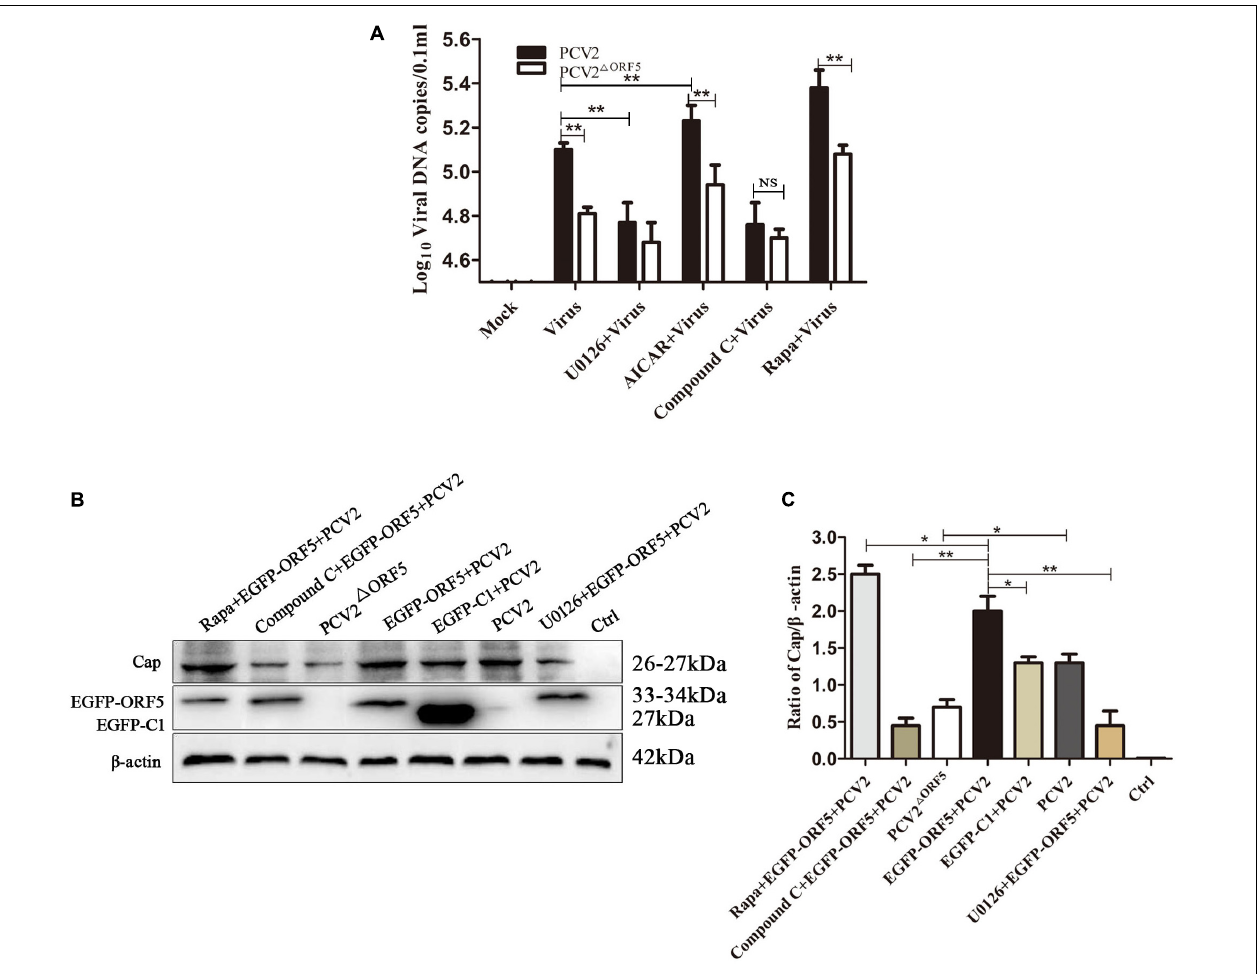
FIGURE 9 | ORF5 protein promotes PCV2 replication via mTOR-ERK1/2-AMPK. (A) PK-15 cells were pretreated with U0126, AICAR, Compound C and Rapa for 2 h and then infected with PCV2 or PCV2 (cid:49) ORF5 . At 36 h post-infection, PCV2 DNA copies were quantified by quantitative PCR. (B) PK-15 cells were pretreated with U0126, AICAR, Compound C and Rapa for 2 h and then infected with PCV2 or PCV2 (cid:49) ORF5 . At 36 h post-infection, Cap protein and GFP protein were detected by immunoblotting. (C) Perform a T -test on the grayscale analysis of the (B) , the ratio of Cap to β -actin. * p < 0.05, ** p <